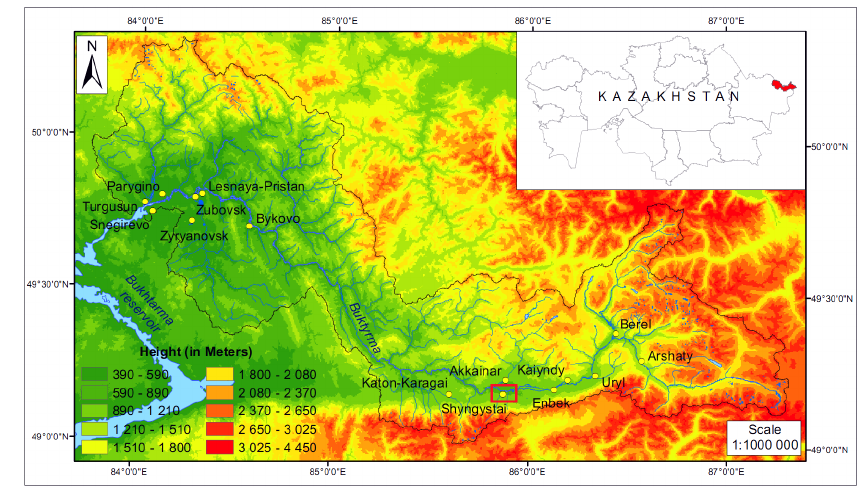
Figure 2. Map of the Buktyrma river